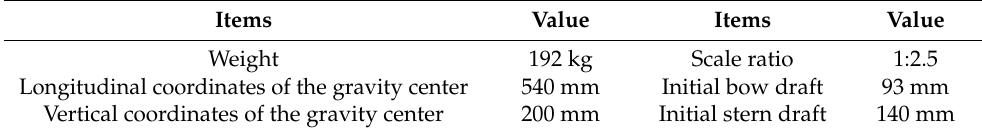
Table 5. Parameters of the model ship.